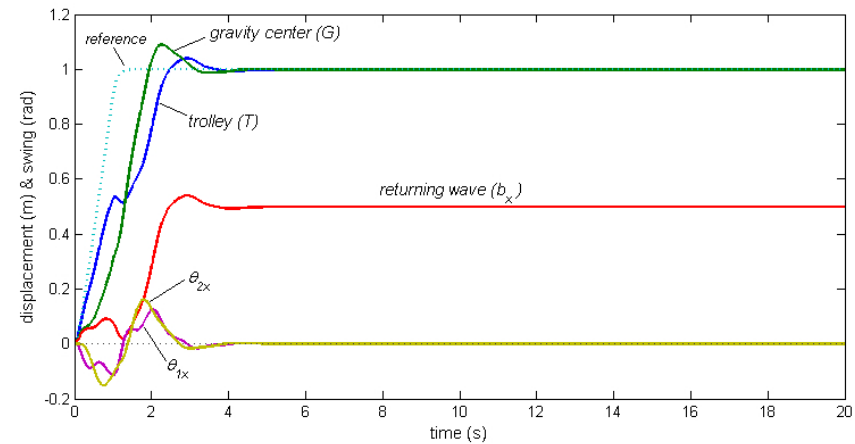
Figure 5. Gantry crane response to a 1m displacement in x direction using WBC.